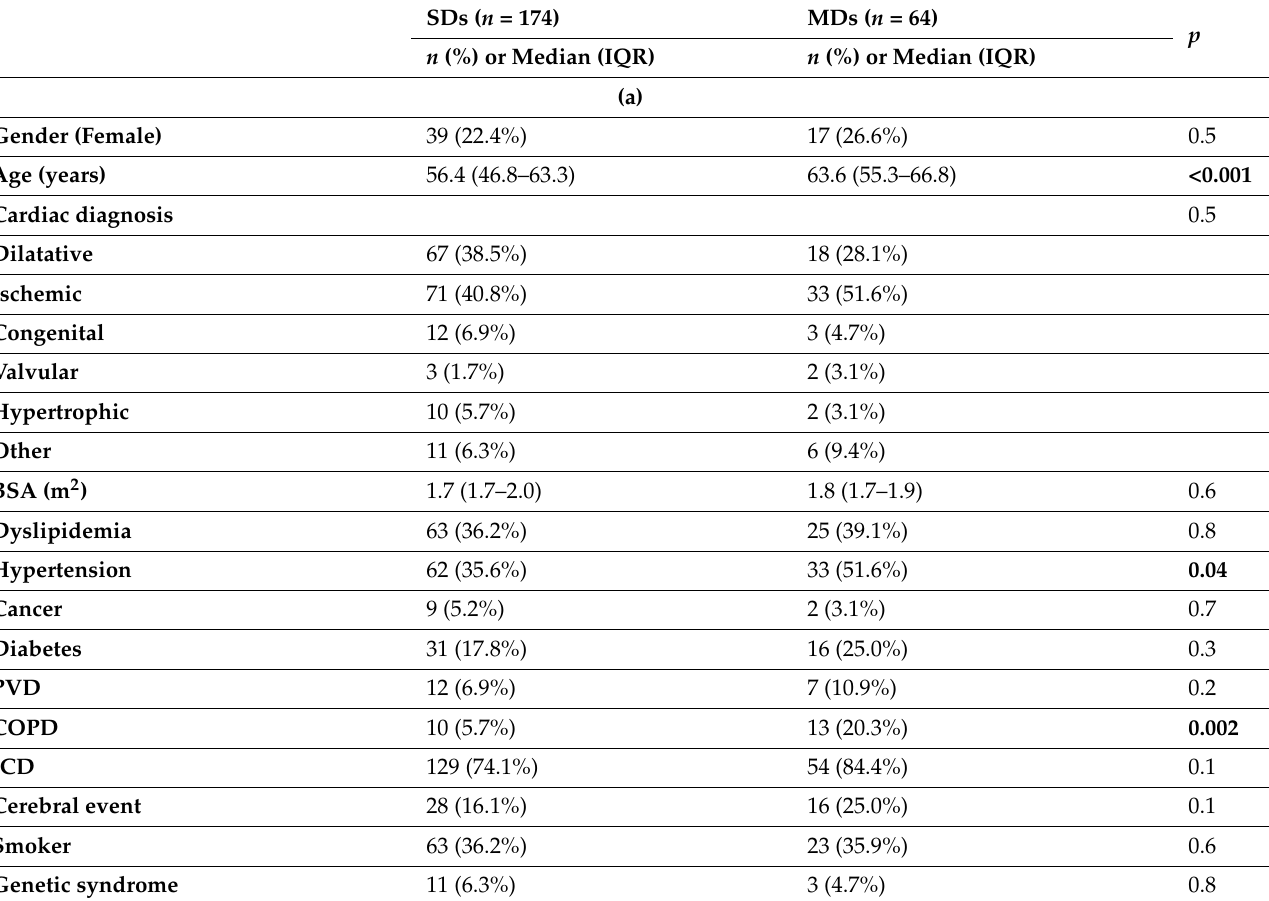
Table 1. (a,b) Basic characteristics of organ recipients from standard versus marginal